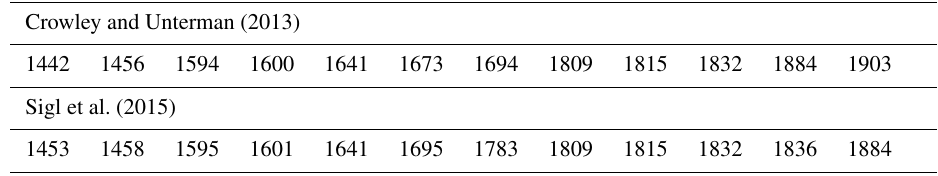
Figure 4. Simulated intra-year partial growth response functions G T (a, c) and G M (b, d) for T -sensitive (a, b) and M -sensitive (c, d) simulations using all climate simulations, with parameters conditioned and validated using observed TRW data within the period 1901– 1970. Heavy solid lines are median values across all simulations. Table 2. Largest volcanic eruptions used in the composite analysis based on atmospheric optical depth (years